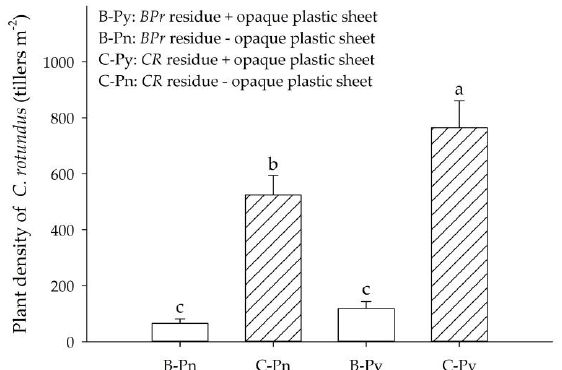
Figure 5. The influence of BPr as a cover plant on the regeneration of CR . Plant density of CR was investigated two weeks after mowing (69 DAS). Error bars are the standard error of mean ( n = 6). Means with the same letter(s) are not significantly different at 5% level by LSD test.